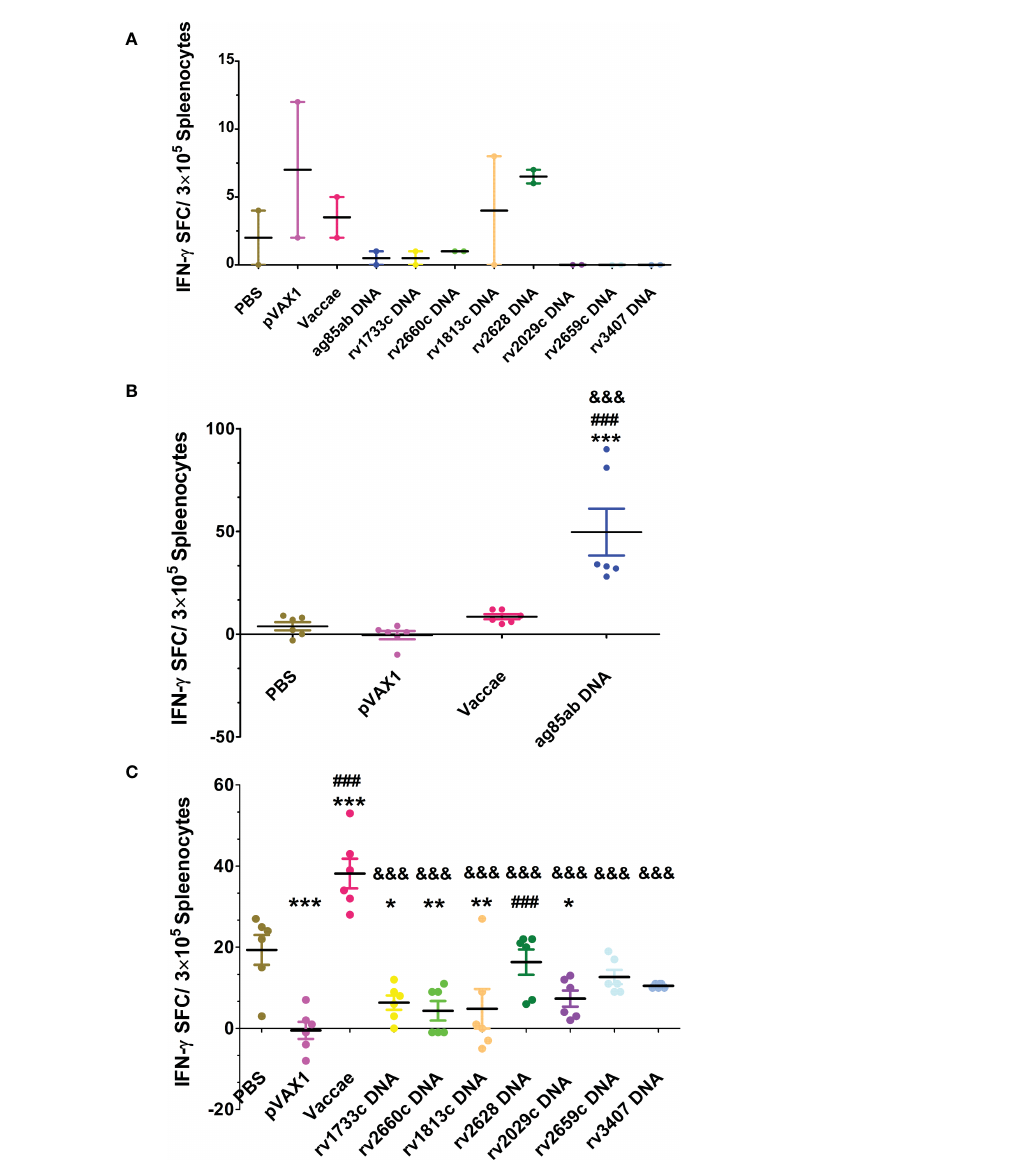
FIGURE 4 The numbers of spleen lymphocyte spots releasing IFN- g was detected by ELISPOT assay at 3 w after stopping hydroprednisone injection. (A) the numbers of splenocyte spots secreting IFN- g in unstimulated wells from each group, (B) stimulate lymphocyte with Ag85AB protein, (C) stimulate lymphocyte with mixed latent proteins. Comparison with PBS group: * P < 0.05, ** P < 0.01, *** P < 0.0001; Comparison with pVAX1 vector group: ### P < 0.0001; Comparison with Vaccae vaccine group: &&& P <